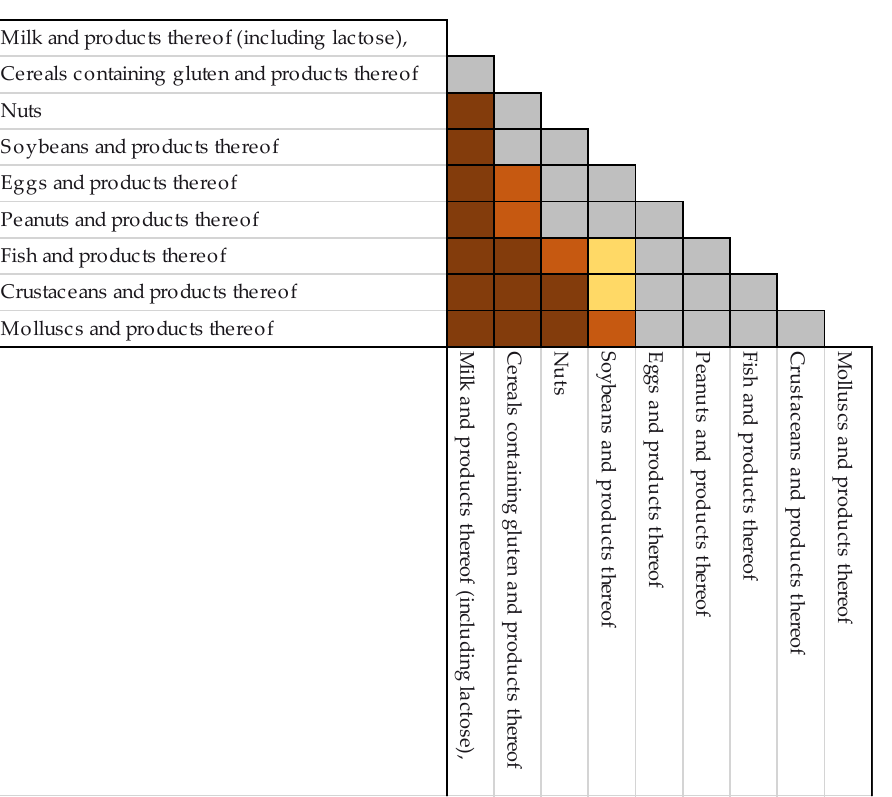
Figure 3. Percentage of total notifications of the main allergens affecting the pediatric population per year.